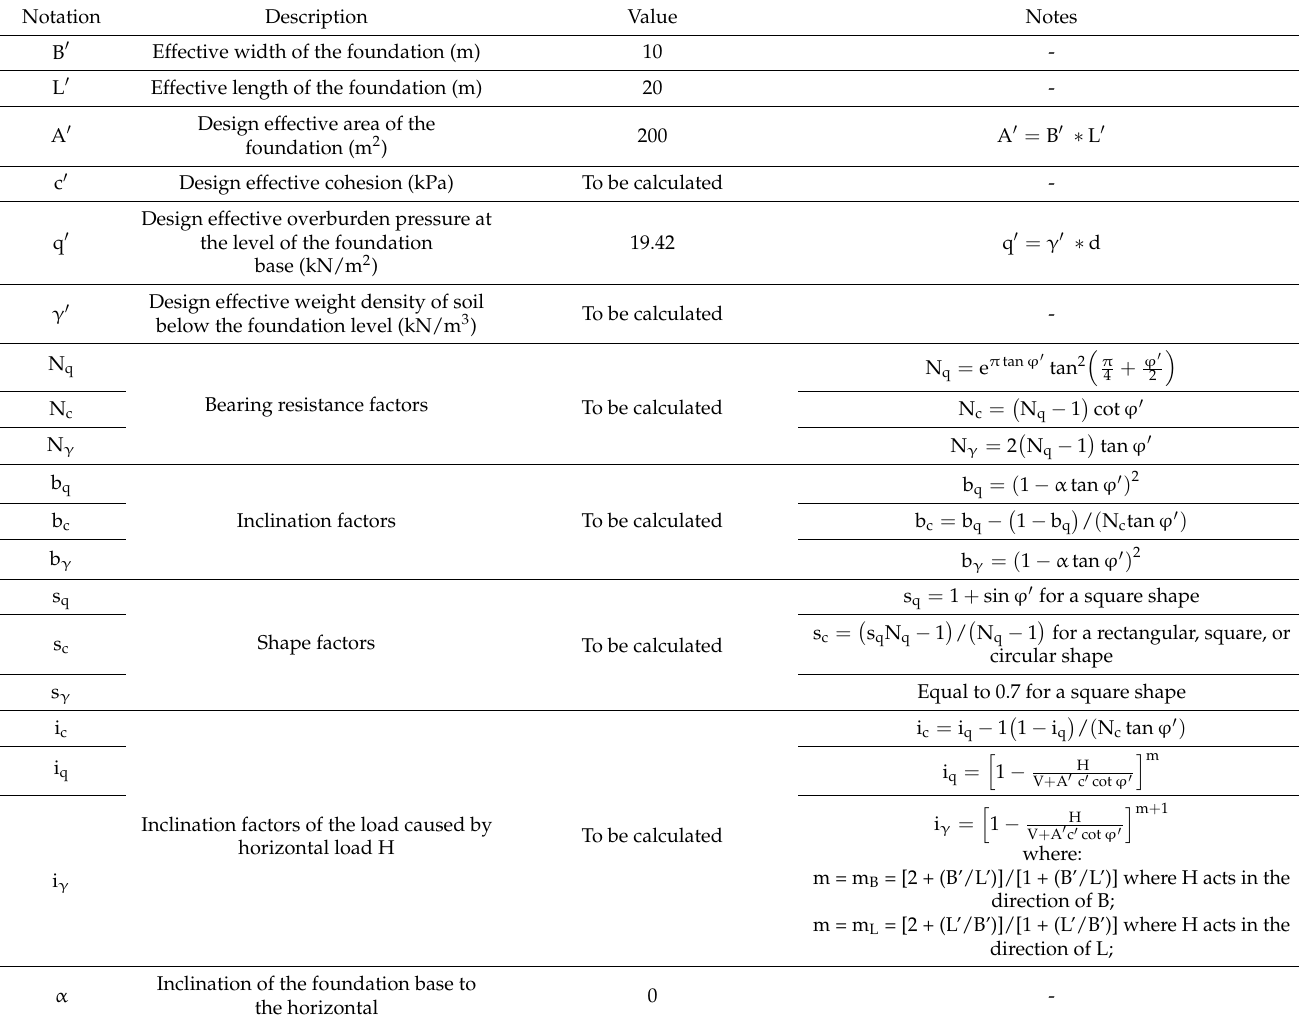
Table 6. Description of parameters in Eurocode